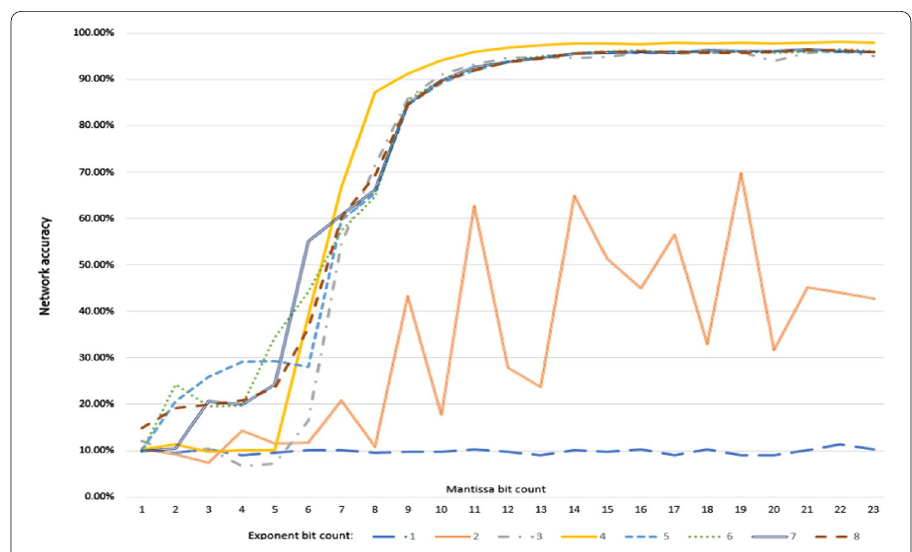
Fig. 5 Neural network accuracy in various exponent and mantissa bit count